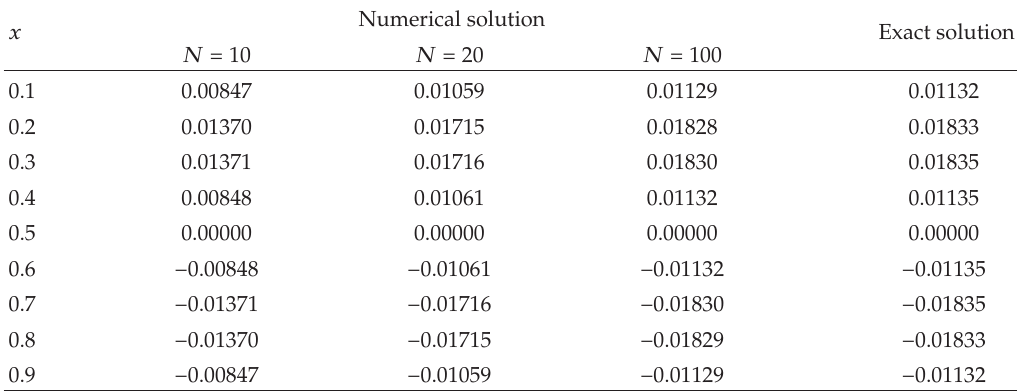
Table 1: Comparison of the LB finite di ff erence solutions with exact solution at T (cid:8) 0 . 1 for ν (cid:8) 1 with τ (cid:8) 1.